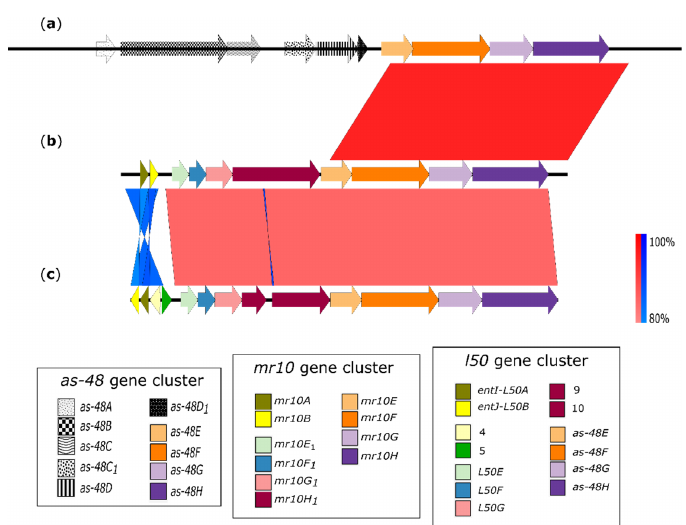
Figure 3. Homology between gene clusters of enterocins AS-48 ( a ), MR10A/B ( b ), and L50A/B ( c ). The color scale represents the similarity between the different genes: light red and blue = 80% similarity, dark red and blue = up to 100% similarity; red corresponds to direct similarity and blue to inverse similarity. Homologies between mr10A/B and as-48 clusters appear in the last four genes corresponding to ABC Transporter-2.